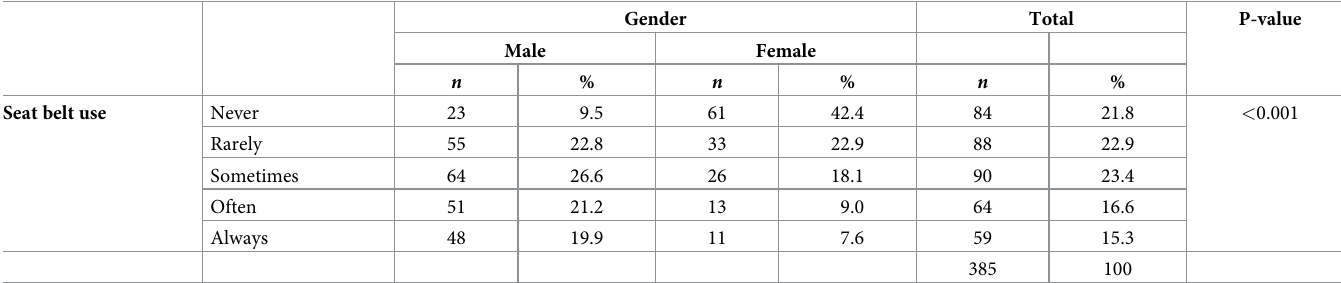
Table 2. Association between seat belt use and